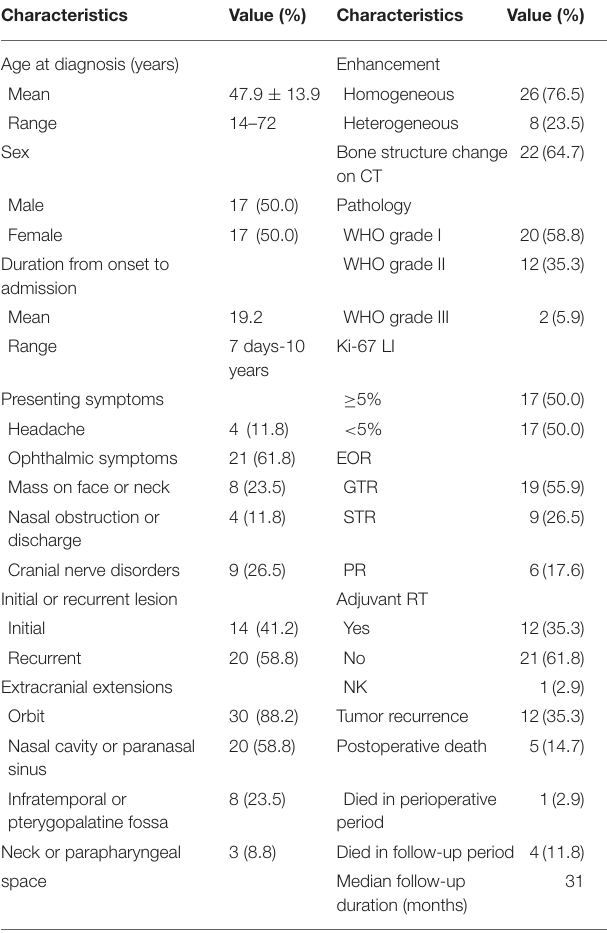
TABLE 1 | Demographic, clinical, and radiological characteristics of 34 patients with skull base meningiomas with extracranial extensions.